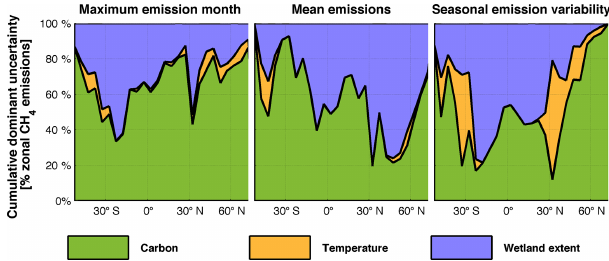
Figure 6. The dominant uncertainty attribution of the maximum CH 4 emission month (left), magnitude (centre) and seasonal vari- ability (right) to carbon decomposition, temperature CH 4 :C depen- dence ( q 10 ) and wetland extent parameterization within 5 ◦ latitude bins. The derivation of dominant uncertainties is described in Ap- pendix